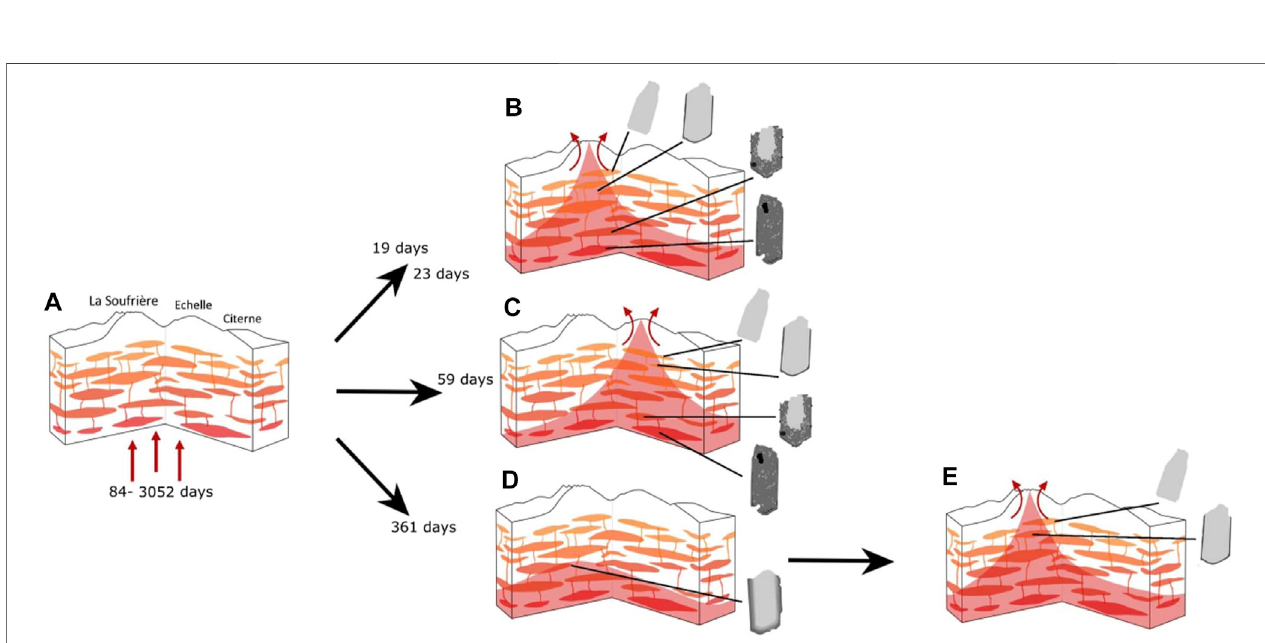
( Table 2 ). This indicates while intrusions may begin at similar times prior to an eruption, the diffusion timescale distribution and resulting expected timescales, suggest the intrusions interact differently with the system. A transition in conduit location to